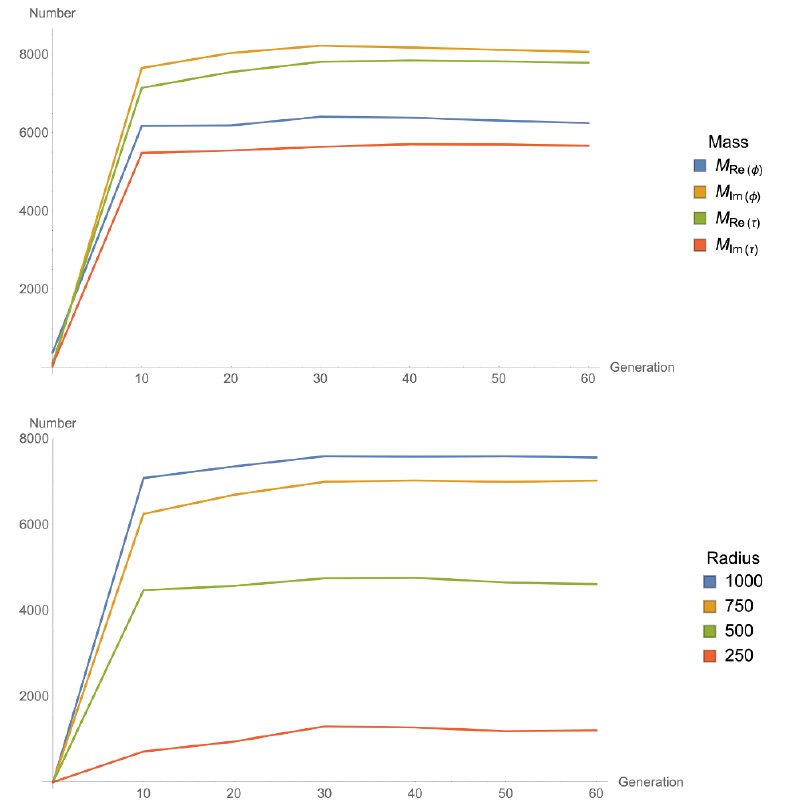
Figure 17 . Top: the number of individuals having a single mass matrix entry within a neighbor- hood of r = 500 using tournament selection. Bottom: the number of individuals having all four masses within di(cid:11)erent